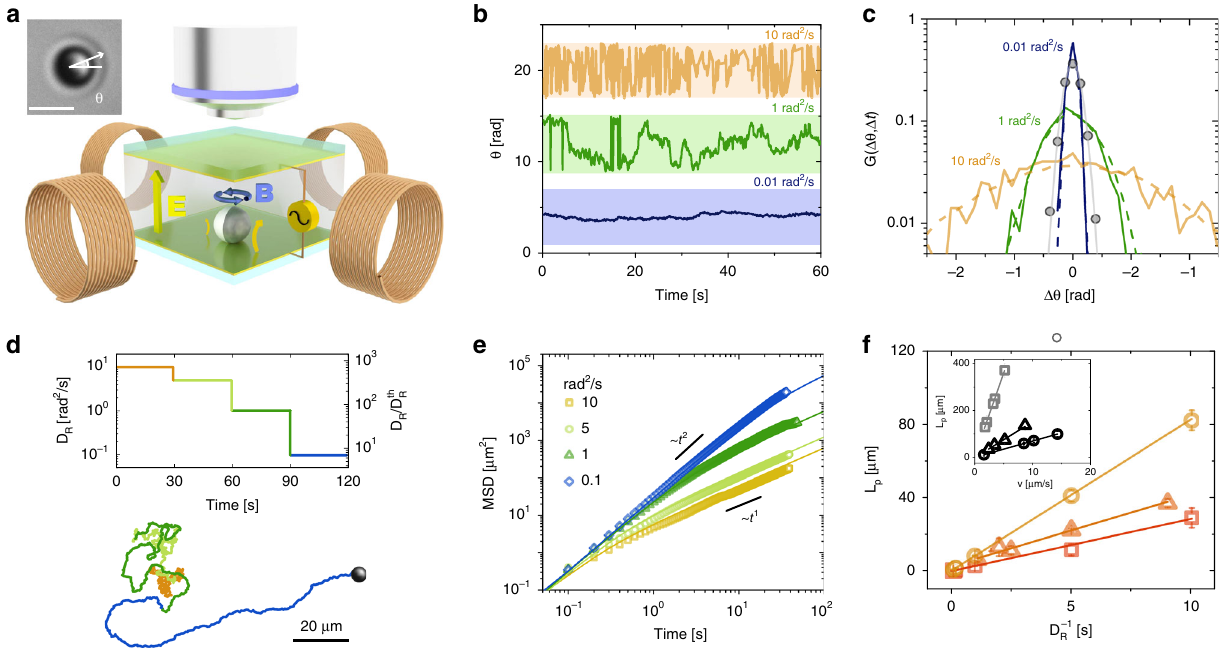
Fig. 1 Controlling rotational dynamics through randomly-oriented magnetic fi elds. a Schematic of the experimental setup. A Janus silica particle, half- coated with a magnetized Ni cap, undergoes self-propulsion at the bottom of a liquid cell enclosed by two transparent electrodes. Propulsion stems from ! induced-charge electro-phoresis generated by an AC electric fi eld E perpendicular to the plane in which the particle moves (the curved yellow arrows ! depict local unbalanced electrohydrodynamic fl ows). A uniform magnetic fi eld B (blue arrow), produced by four coils, controls the in-plane orientation of the particle, while its motion is observed with an optical microscope. The inset shows an optical micrograph of a 4 μ m particle, with the Ni cap in black. The white arrow shows the particle ’ s orientation angle θ , which is aligned with the cap ’ s magnetic moment and thus with the magnetic fi eld. Scale bar: 5 μ m. b Imposed θ as a function of time for three values of D R . The colored bands delimit a 2 π range. Data are shifted along the y -axis for clarity. c Probability distributions of angular displacements G( Δ θ , Δ t ) for different D R and lag time Δ t = 0.1 s (dashed lines: imposed Δ θ , solid lines: measured Δ θ ) with the (gray line: Gaussian fi t, same colors as in b . The gray symbols show the measured G( Δ θ , Δ t ) without magnetic fi eld, corresponding to the thermal D th R see Supplementary Table 1). d Trajectory of an ABP with v = 5.5 μ m s − 1 and an imposed D R varying over time. e MSD of an ABP with v = 5.5 μ m s − 1 for different imposed D R : 0.1 (diamonds), 1 (triangles), 5 (circles) and 10 (squares) rad 2 s − 1 (colors as in d ). f Persistence length ( L P ) as a function of rotational relaxation time D (cid:2) 1 for different values of v : 8.2 (circles), 6.7 (triangles), and 2.7 (squares) μ m s − 1 . The inset shows L P as a function of v for the R = 0.014 rad 2 s − 1 (gray squares) and for an imposed D 2 s − 1 (black triangles and circles, respectively). Error bars thermal D th R of 0.07 and 0.144 rad R correspond to the data standard inset show that L P can be varied over a wide range of values, displaying the expected linear scaling on both control parameters.